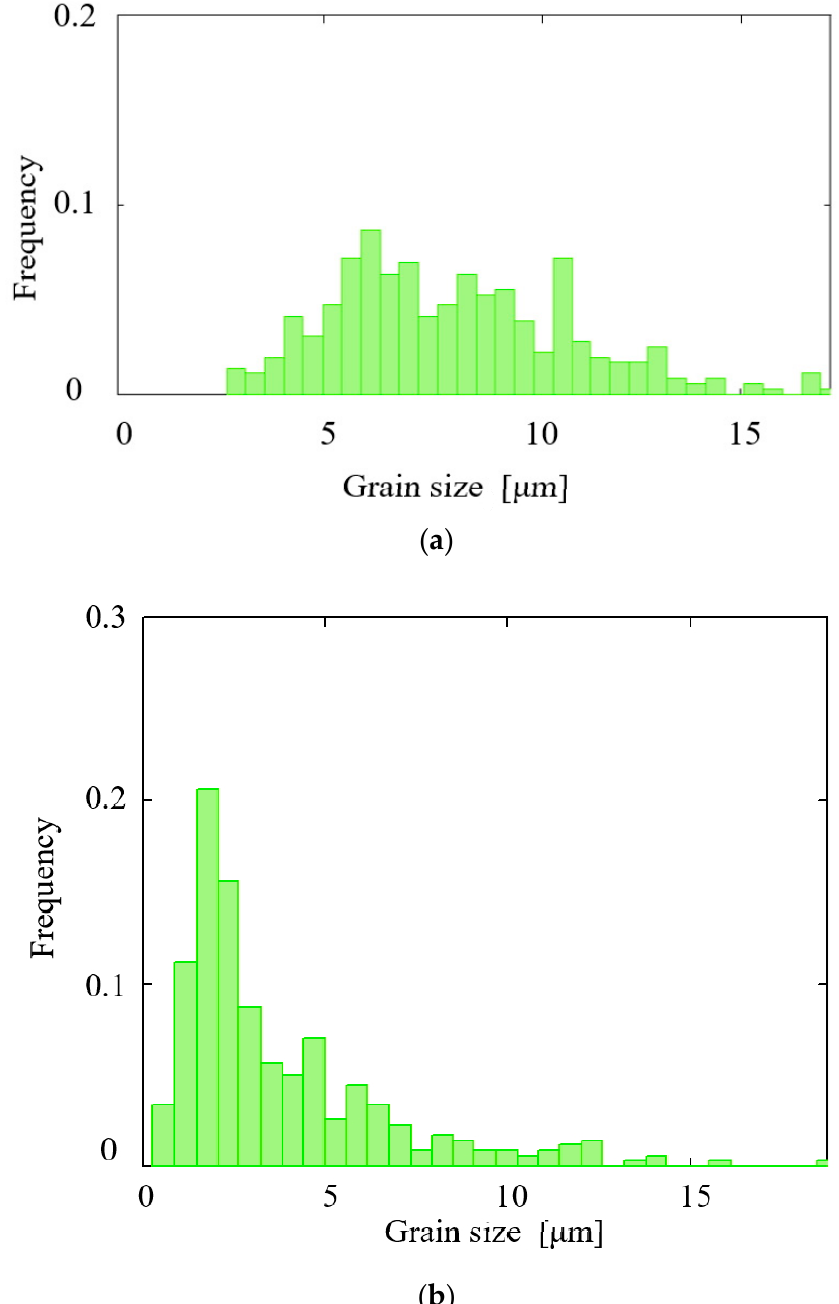
Figure 8. Histograms of the α -phase ( a ) and β -phase ( b ) grain size distribution in the cross section of the billet after radial shear rolling. When plotting the histograms, different numbers of intervals were chosen (10 or more). The histograms had one or several maximums with frequencies 0.05 or less (as in Figure 8), or the histograms had only two maximums with frequencies 0.1 or more. The observed number of clearly visible columns (maximums) confirmed the above assumption that the grain size distribution was formed of two